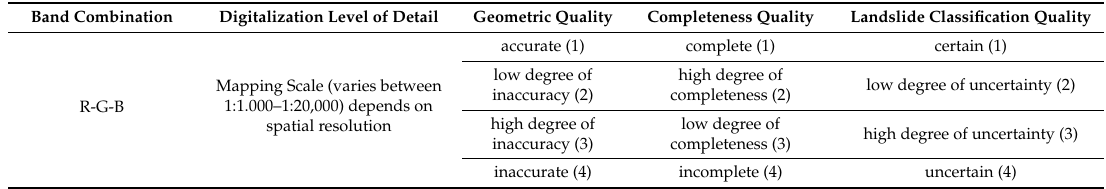
Table 3. Database fields that describe how the remote sensing image quality influences the manual landslide